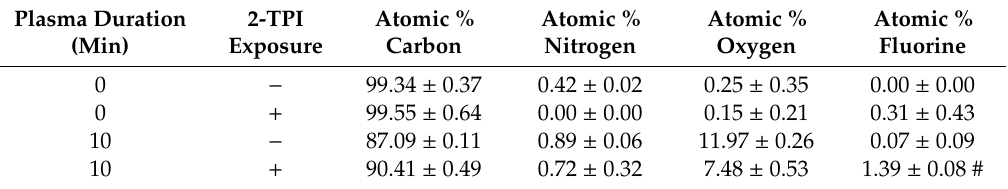
Figure 7. Representative XPS survey scans (rescaled to normalize areas under curves) of PP after 0 or 10 min plasma, plus equivalent exposure to 2-TPI. Increased isocyanate binding is indicated by the appearance of an F1 s peak (arrow) only for the 10 min plasma sample. KLL peaks were not used for analysis. Spectra are intentionally offset from each other along the vertical axis. Table 4. Effect of plasma treatment on isocyanate-mediated fluorination of PP surfaces.